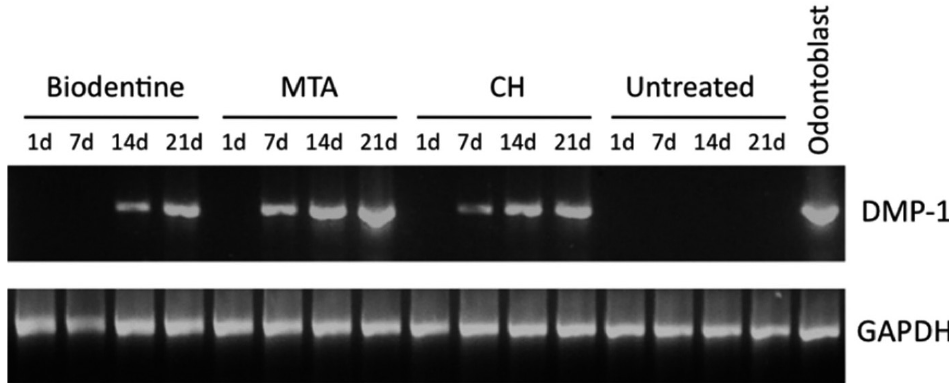
Figure 4- RT-PCR analysis of dentin matrix protein-1 (DMP-1, 213 bp) and glyceraldehyde-3-phosphate dehydrogenase (GAPDH, 683 bp) mRNA expression on stem cells from human exfoliated deciduous teeth (SHED) cultured with calcium hydroxide (CH), mineral trioxide aggregate (MTA) or Biodentine TM (BD) conditioned medium or regular growth medium (alpha-MEM supplemented with 10% FBS, negative control) for 21 days. Positive controls were odontoblasts retrieved from freshly extracted human third